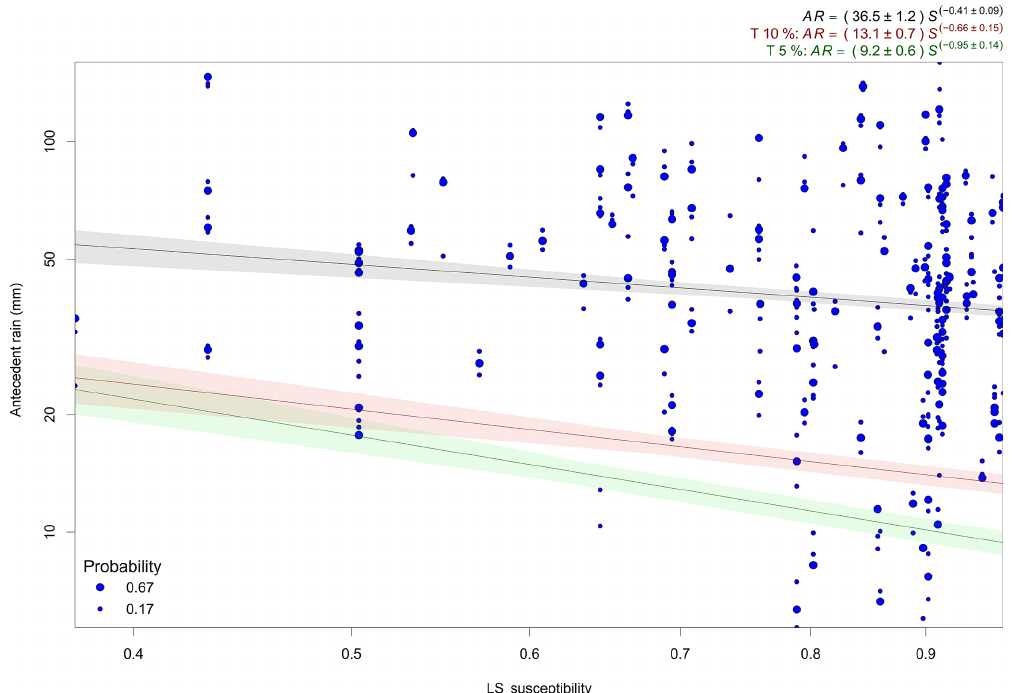
Figure 4. Log–log plot of antecedent rain (mm) vs. ground susceptibility to landsliding for the recorded landslides, with their associated sampling probability: 0.67 at the reported landslide date; 0.17 at the days prior to and after the reported landslide date. The black curve is the regression curve obtained from the whole data set; the green and red curves are the AR thresholds at 5% and 10% exceedance probability levels respectively, along with their uncertainties shown as shaded